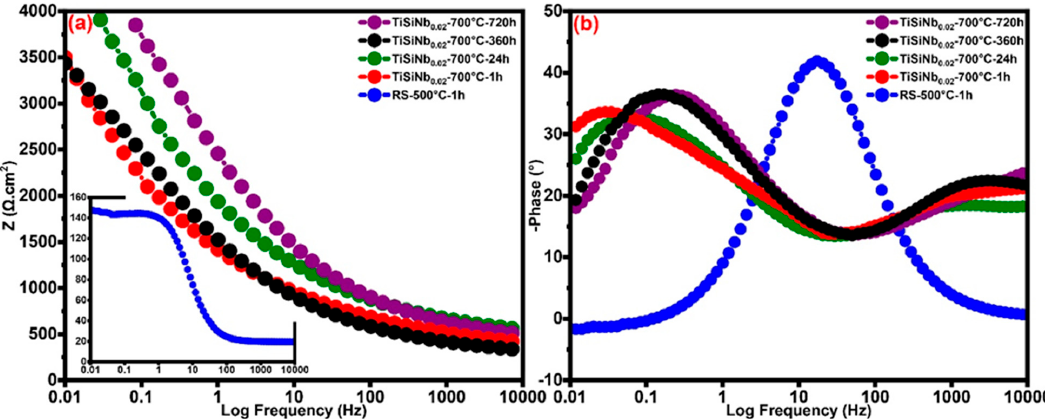
Figure 9. Bode plots ( a ) and Bode phase diagrams ( b ) for RS and TFSOC for different immersion time in SCS. in